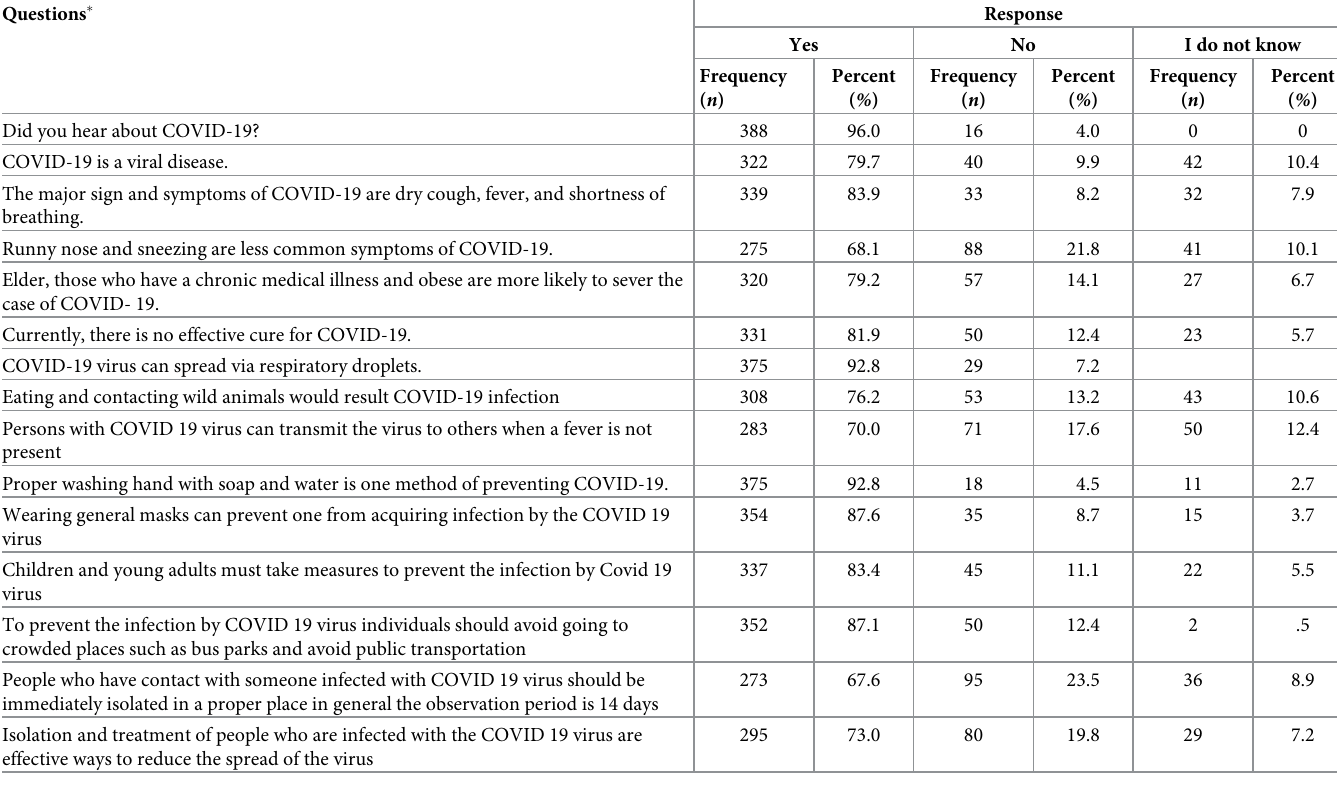
Table 2. Knowledge of hospital visitors towards COVID-19 prevention in hospitals of South Gondar zone, Northwestern Ethiopia, August 1 to 30, 2020. Questions �